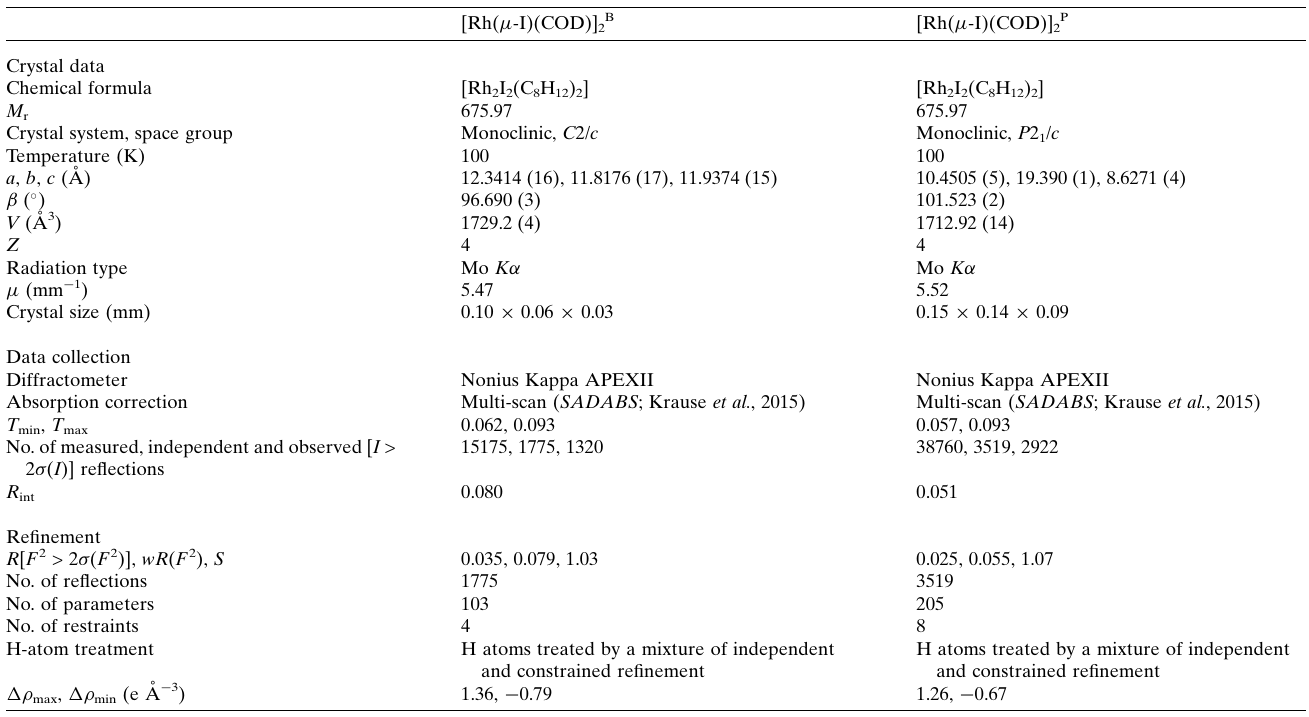
Table 1 Experimental details.